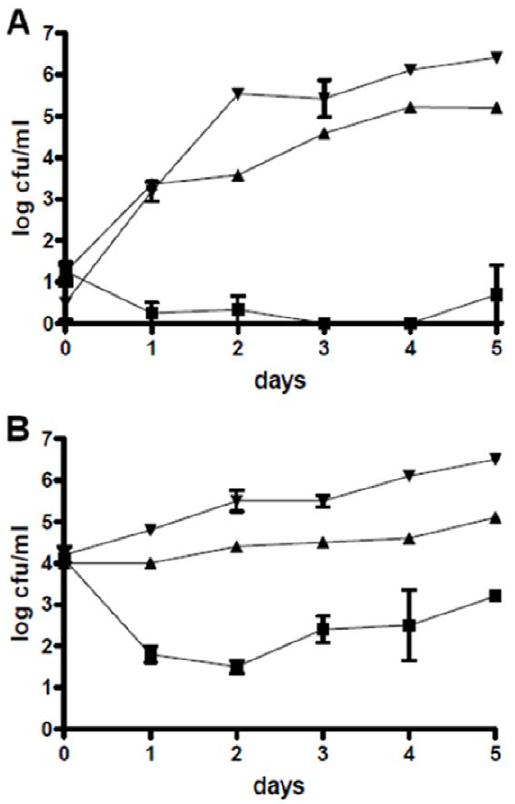
Figure 3. Reduction of V.anguillarum in cultures of Tetraselmis suecica by Phaeobacter gallaeciensis . Colony-forming units of V. anguillarum inoculated at 10 1 cfu/ml (A) and at 10 4 cfu/ml (B) in presence of P. gallaeciensis wild type ( & ), in presence of the P. gallaeciensis TDA-negative mutant ( m ), and in the monoxenic control ( . ).